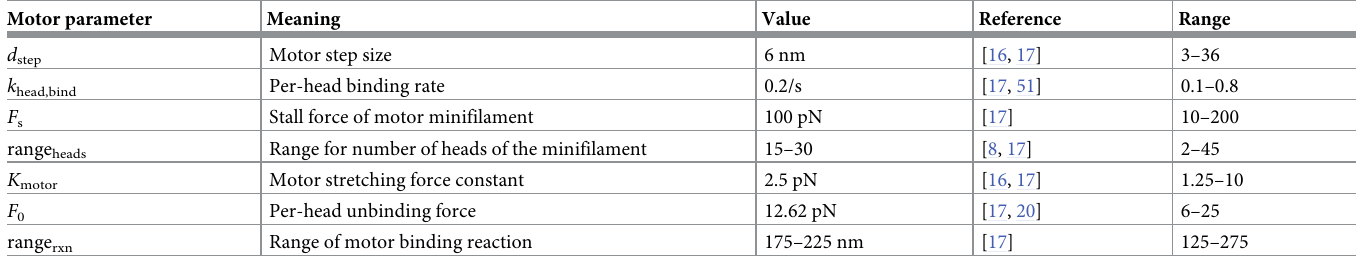
Table 1. Baseline parameters for the myosin II minifilaments from